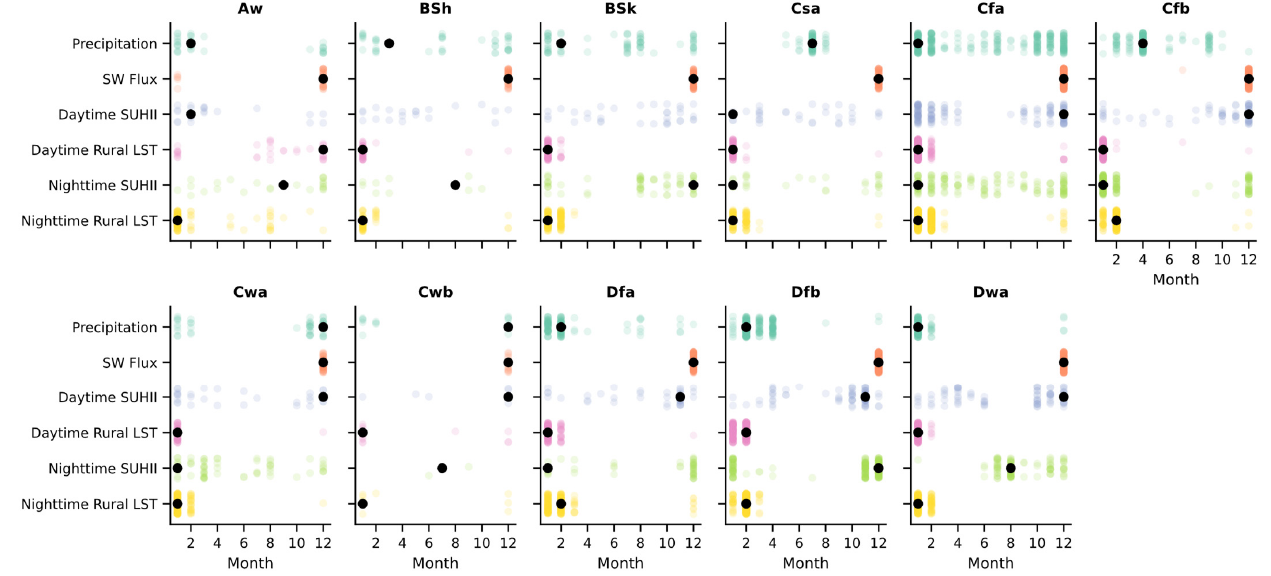
Figure 9. The month when SUHII, rural LST, SW flux, and precipitation are minimum. The colored dots represent the individual SUHII loops, and the black dots the Köppen–Geiger climate-class mean loop (BSh and BSk are not included).